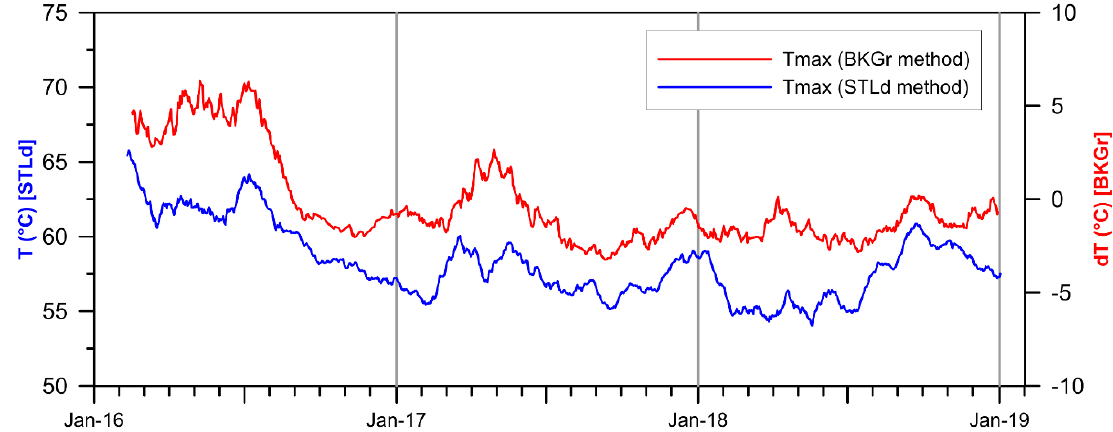
Figure 10. Plots of temperatures acquired at SF1 station removed of seasonal component. Red line = 375